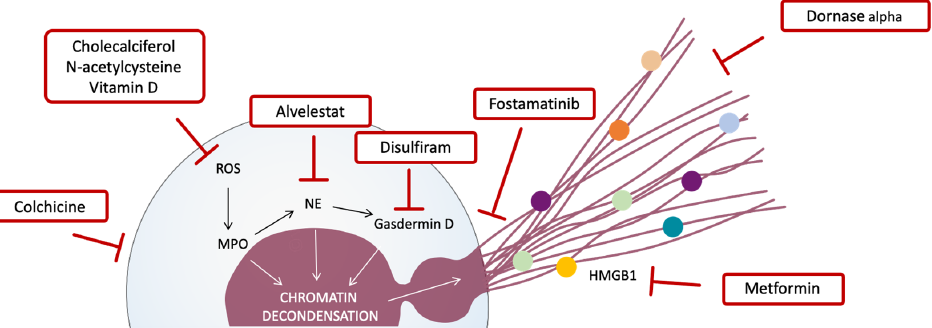
Figure 2. Potential drugs for COVID-19 treatment that target some step of NETs release and formation. Drugs targeting different steps of NETosis and NETs formation. Colchicine inhibits neutrophil activation. The presence of reactive oxygen species (ROS) is one of the first inducers of NETosis, and drugs such as cholecalciferol, N-acetylcysteine, and vitamin D can reduce ROS formation. ROS induce myeloperoxidase (MPO) activation, which activates neutrophil elastase (NE) and subsequently activates gasdermin D. MPO, NE, and gasdermin D promote chromatin decondensation, and gasdermin D also permeabilizes the membrane and creates pores in order to release DNA filaments and different proteins that compose NETs. In this regard, alvelestat and disulfiram block NE and gasdermin D, respectively; fostamatinib inhibits NETs release; dornase alfa degrades DNA filaments; and metformin inhibits HMGB1, a protein involved in platelet–NETs interactions, which triggers a loop of NETs release.